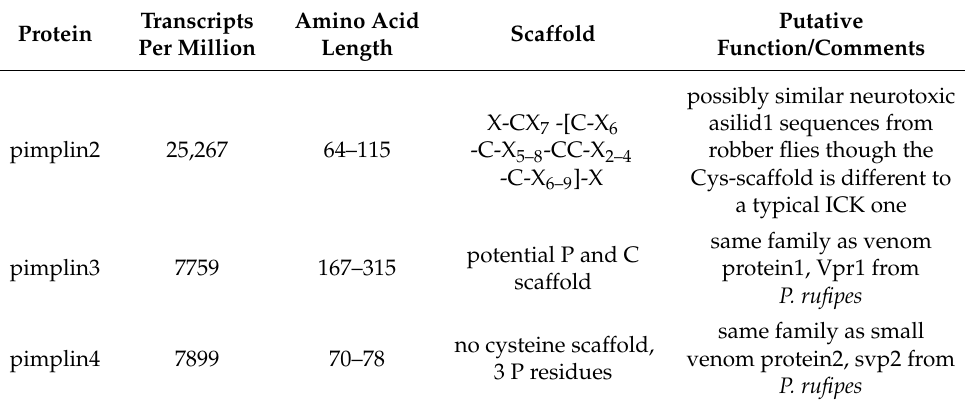
Table 10. Named venom proteins identified in the venom of P. turionellae and attributes. (Source adapted from [57] under the terms of Creative Commons Attribution Licence CC-BY 4.0 via MDPI Toxins ). Putative Transcripts Amino Acid Scaffold Protein Per Million Length